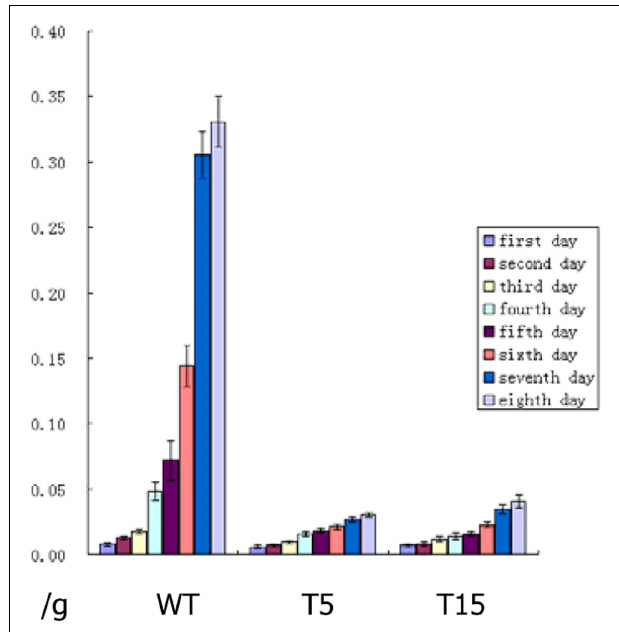
FIGURE 3 | Daily average weight of larvae after feeding bioassay. WT: Daily average weight of 12 larvae fed with larva fodder mixture containing wild-type sugarcane stem tissue, they grew fast from first day to eighth day; T5: Daily average weight of 12 larvae fed with larva fodder mixture containing the T5 transgenic line stem tissue, they grew much slower than wild type from first day to eighth day; T15: Daily average weight of 12 larvae fed with larva fodder mixture containing T15 transgenic line stem tissue, they grew much slower than wild type too from first day to eighth